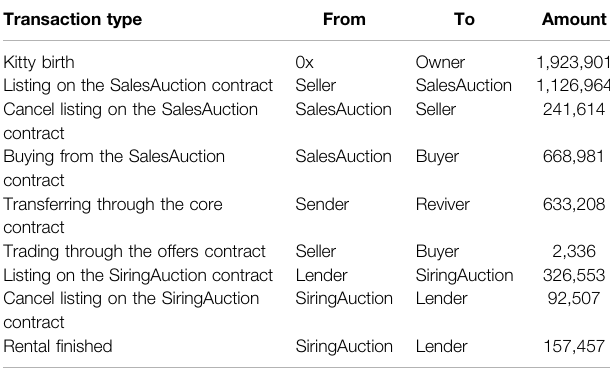
TABLE 2 | Nine types of transactions related to the movements of kitties. Transaction